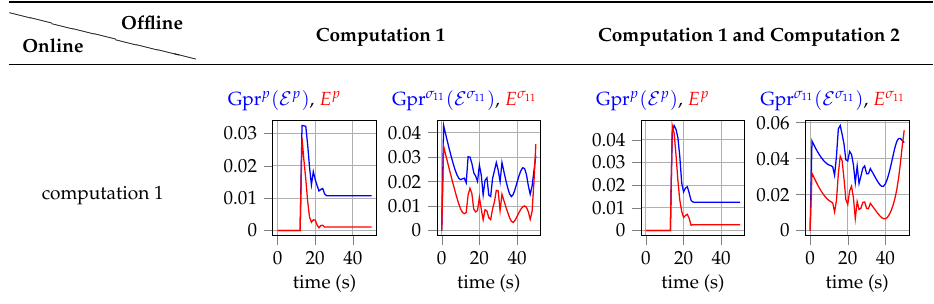
Table 4. Comparison of the error indicator (19) with the error (12) for various offline and online variabilities, with enrichment of the reduced order